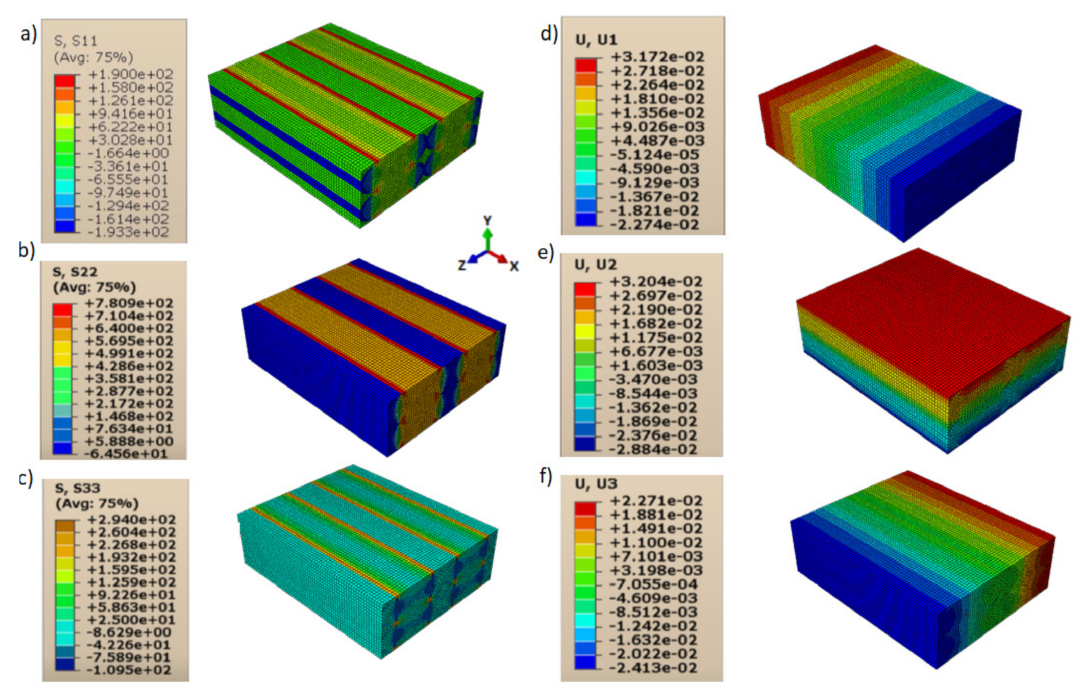
Polymers 2021 , 13 , x FOR PEER REVIEW Figure 11. Load cases to evaluate E 22 : ( a ) stress in direction 11; ( b ) stress in direction 22; ( c ) stress in direction 33; ( d ) displacement in direction 11; ( e ) displacement in direction 22; ( f ) displacement in direction 33.